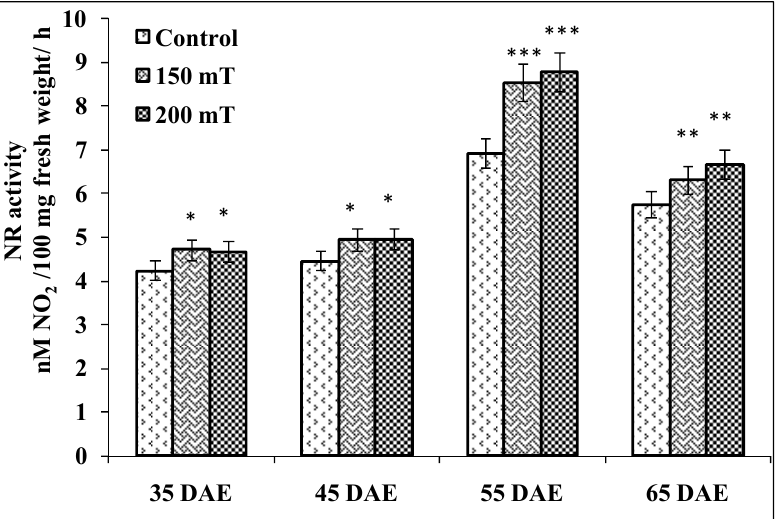
Figure 16. Effect of pre-sowing exposure of soybean seeds to magnetic field on nitrate reductase activity. ***, ** and * indicate significance at p < 0.001, 0.01 and 0.05, respectively, compared to control.